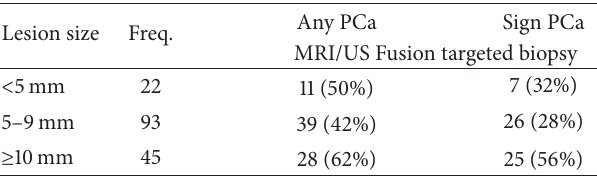
Table 2: PI-RADS score and cancer detection rates ( 𝑛 = 148 ). PI-RADS